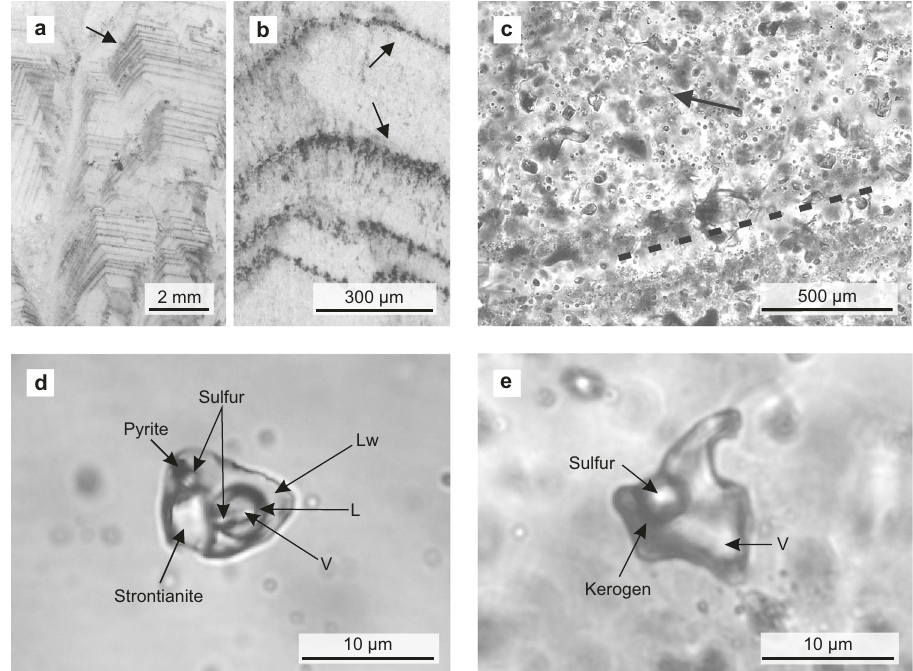
Fig. 2 Fluid inclusions in representative black barites from the Dresser mine. a , b Thin section images (re fl ected light) showing primary fl uid inclusion trails parallel to barite crystal growth bands (marked by black arrows). c Thin section image (transmitted light) showing primary fl uid inclusions which are dispersed or oriented parallel to barite crystal growth bands (exempli fi ed by dashed line). The image also shows a minor secondary inclusion trail (marked by black arrow). d Thick section image (transmitted light) of an aqueous carbonic-sulfuric fl uid inclusion containing three volatile phases (including H 2 S), plus pyrite, native sulfur, and strontianite as solid phases. e Thick section image (transmitted light) of a non-aqueous fl uid inclusion bearing a vapour phase, native sulfur, and kerogen. These fl uid inclusions are usually rich in H 2 S. V vapour/gas, Lw liquid H 2 O, L other liquid (e.g. CO 2 ). Organic compounds and gases preserved in these primary fl uid inclusions could have provided a substrate to primordial microbial life in the Dresser